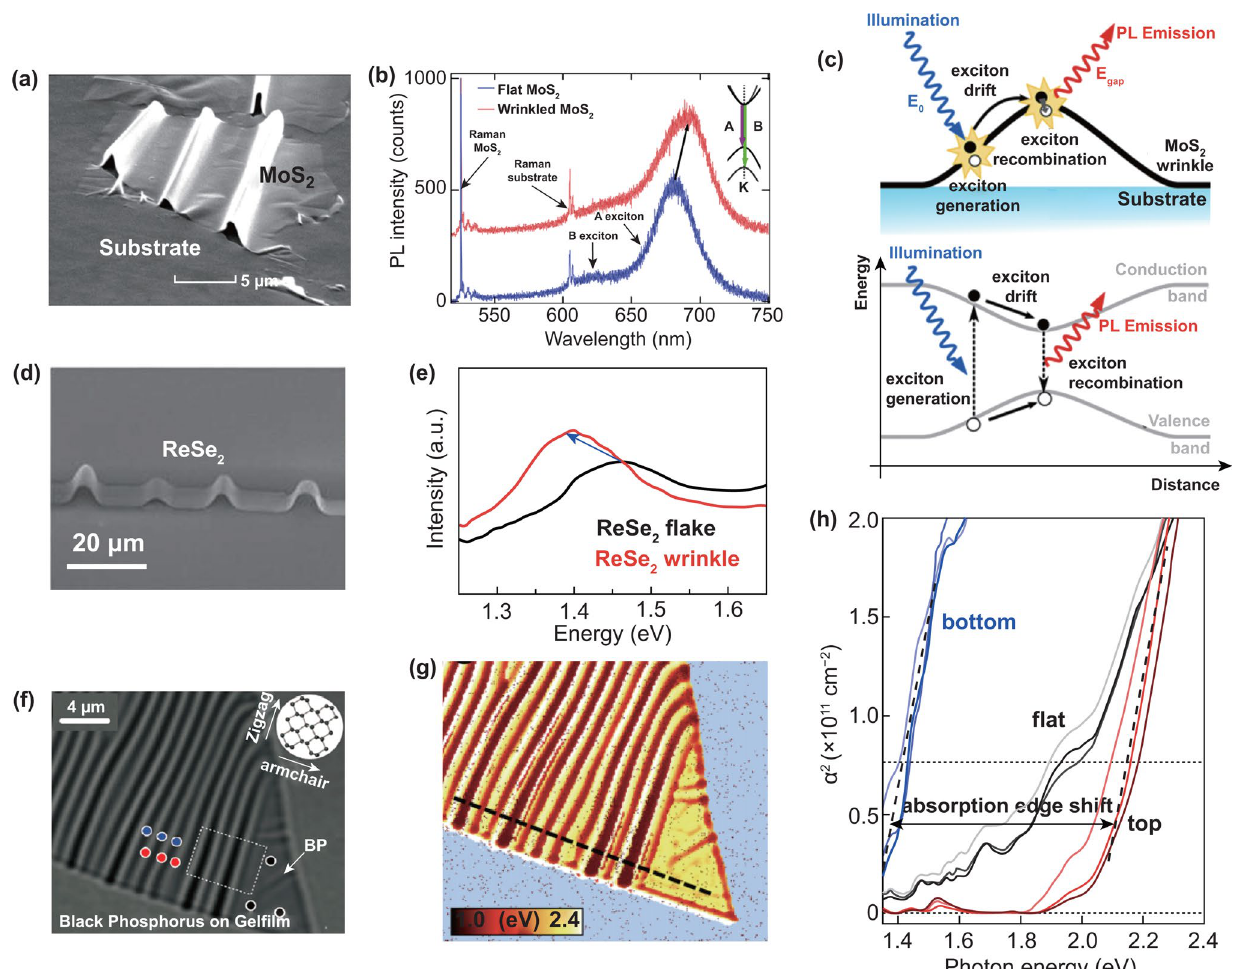
Fig. 9 Observed piezoresistive effect in wrinkles 2D materials. The SEM image of a MoS 2 and d ReSe 2 wrinkles. PL spectra measured on the flat and on the wrinkle regions of b MoS 2 and e ReSe 2 . c Band diagram in the wrinkled MoS 2 . a–c Reproduced with permission [152]. Copy- right 2013, American Chemical Society. d, e Reproduced with permission [153]. Copyright 2015, American Chemical Society. f Optical image of a wrinkled 10-nm-thick black phosphorus flake and g corresponding optical absorption mapping. h Optical absorption spectra acquired on ripple summits, valleys and flat regions. Reproduced with permission [154]. Copyright 2016, American Chemical